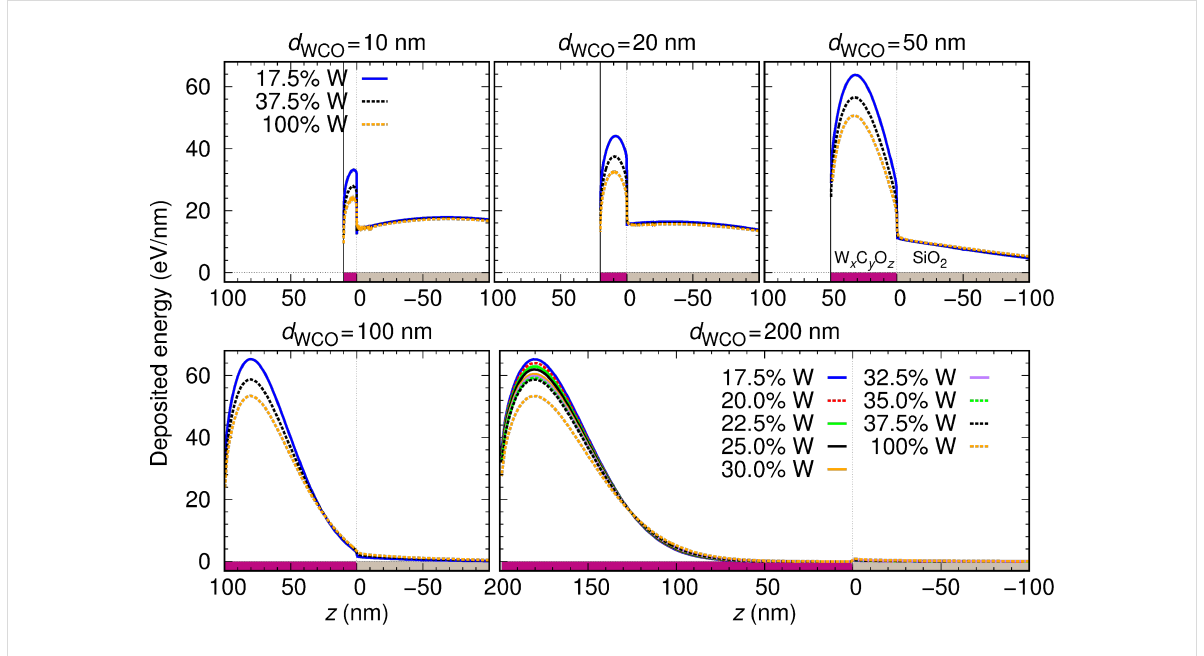
Figure 8: Same as Figure 7 for a fixed deposit density ( ρ = 10.6092 g/cm 3 ) and a variable tungsten content.